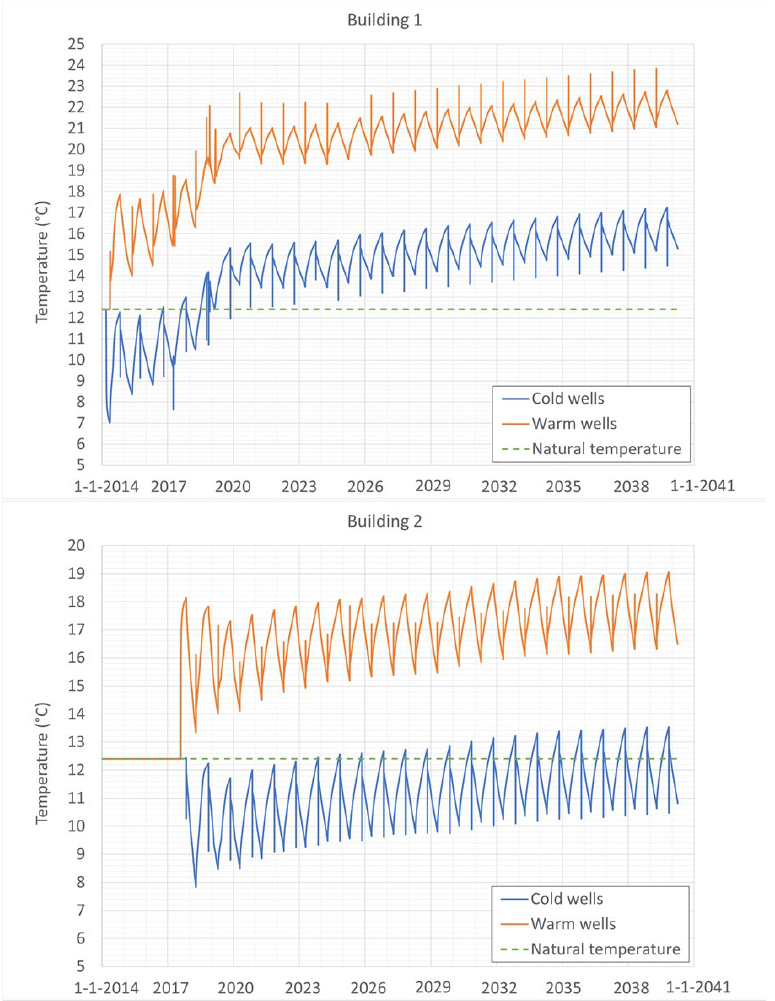
Figure 7. Simulated long-term evolution of the mean temperature in the hot and cold wells starting from the natural background temperature of groundwater around 12.4 °C for Buildings 1 ( above ) and 2 ( below ).